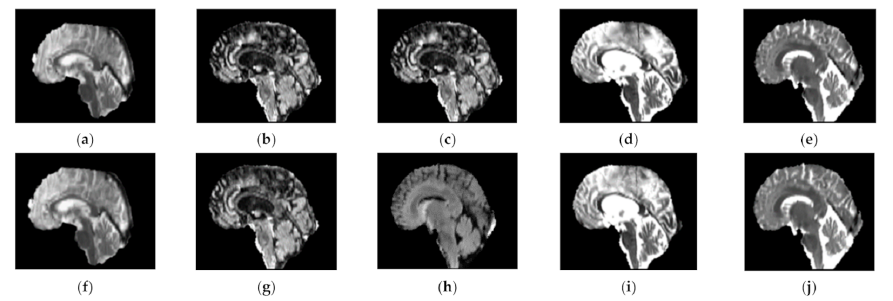
Figure 2. BraTS MR images, before ( top row ) and after ( bottom row ) Gibbs ringing artifact removal. Each MR image in top row ( a – e ) has the corresponding Gibbs ringing artifact-removed MR image ( f – j ) in the bottom row. All the images shown here are T1ce-saggital (for fair comparison). However, other sequences, i.e., FLAIR, T1 and T2 can also be addressed for ringing